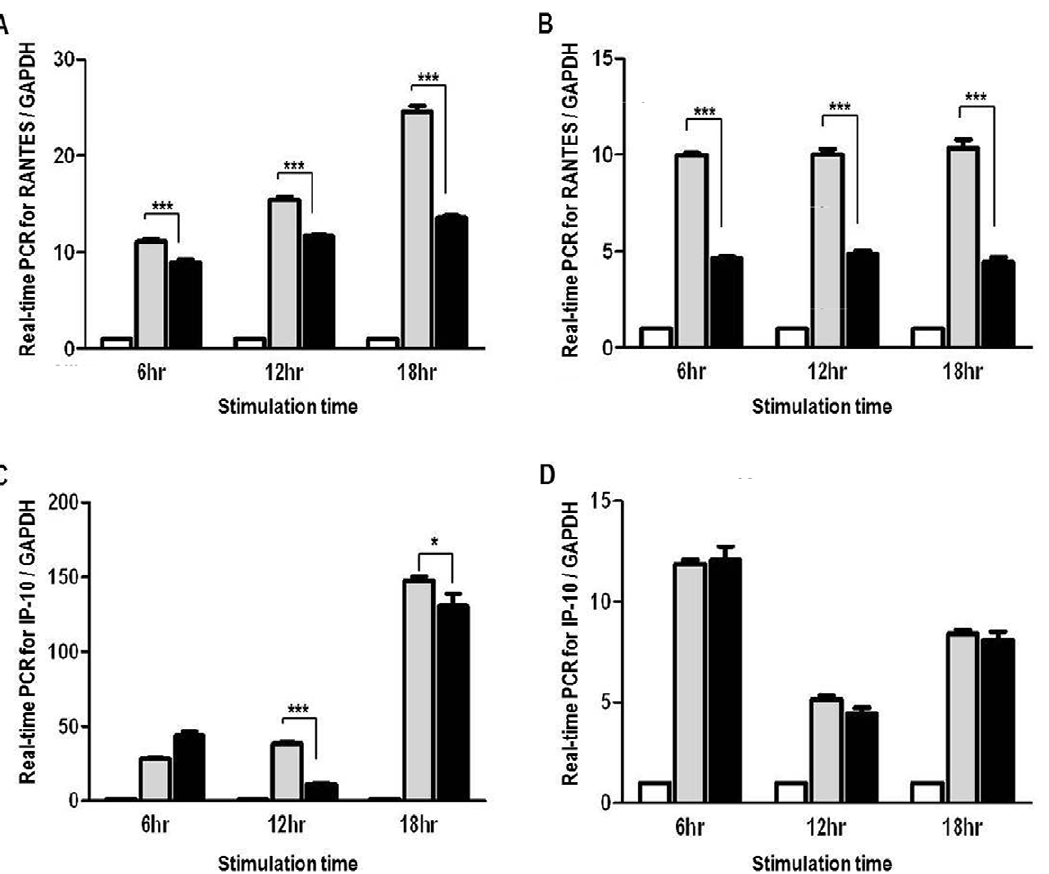
Figure 6. Anti-inflammatory effects of fibroblasts from the hHO-1-Tg pig. A: Expression of the RANTES gene in hHO-1-Tg fibroblasts compared with wild-type fibroblasts in response to hTNF- a stimulation (20 ng/ml) for 6, 12 or 18 hr. RANTES mRNA was measured by real-time PCR. B: Expression of the RANTES gene in hHO-1-Tg fibroblasts compared with the wild-type fibroblasts in response to LPS stimulation (1 m g/ml) for 6, 12, or 18 hr. RANTES mRNA was measured by real-time PCR. C: Expression of the IP-10 gene in hHO-1-Tg fibroblasts compared with the wild-type fibroblasts in response to hTNF- a stimulation (20 ng/ml) for 6, 12 or 18 hr. IP-10 mRNA was measured by real-time PCR. D: Expression of the IP-10 gene in hHO-1-Tg fibroblasts compared with the wild-type fibroblasts in response to LPS stimulation (1 m g/ml) for 6, 12, or 18 hr. IP-10 mRNA was measured by real-time PCR. (* p , 0.05, *** p , 0.001, White bars: control, gray bars: WT cell, black bars: HO-1-Tg cells).